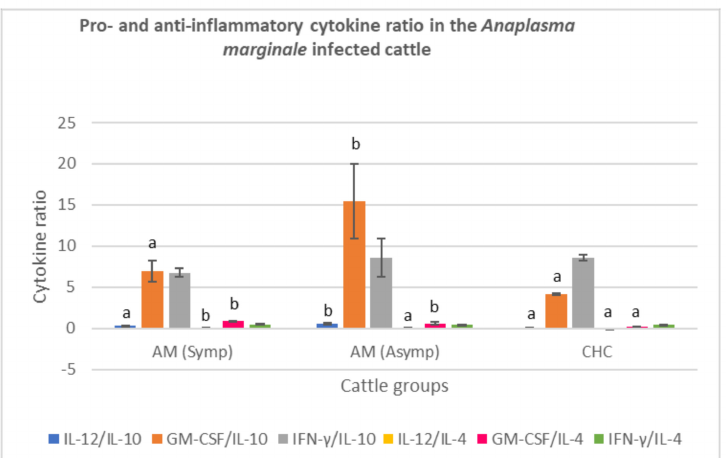
Figure 3. Pro- and anti-inflammatory cytokine ratio in symptomatic and asymptomatic cattle infected with A. marginale. Molecular detection and confirmation of A. marginale was by PCR amplification of the MSP4 gene. High serum GM-CSF:IL-4 level was observed in both symptomatic and asymptomatic A. marginale infected cattle. AM (Symp): Symptomatic Anaplasma marginale infected cattle, AM (Asymp): Asymptomatic Anaplasma marginale infected cattle. CHC: Clinically healthy cattle (control): IL-12: Interleukin 12; IL-10: Interleukin 10; GM-CSF: Granulocyte Macrophage-colony stimulating factor; IFN- γ : Interferon gamma; IL-4: Interleukin 4. ( a , b ) Different superscripts refer to significant differences in the parameters between A. marginale infected cattle and clinically healthy cattle ( p < 0.05).